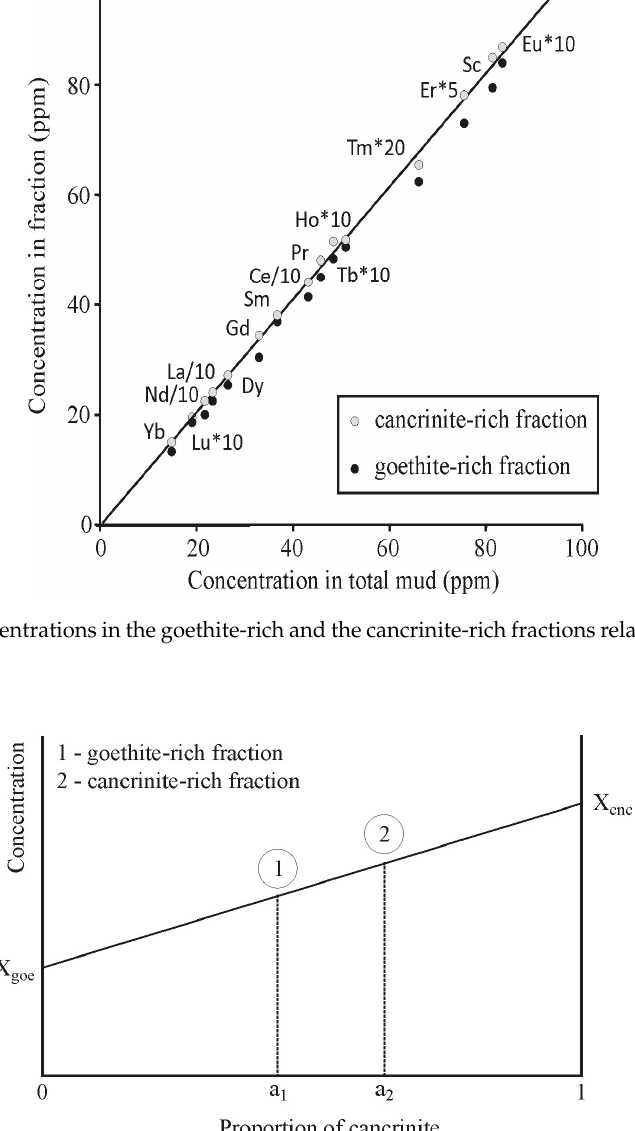
Figure 7. The theoretical background of the linear mixing modeling procedure.